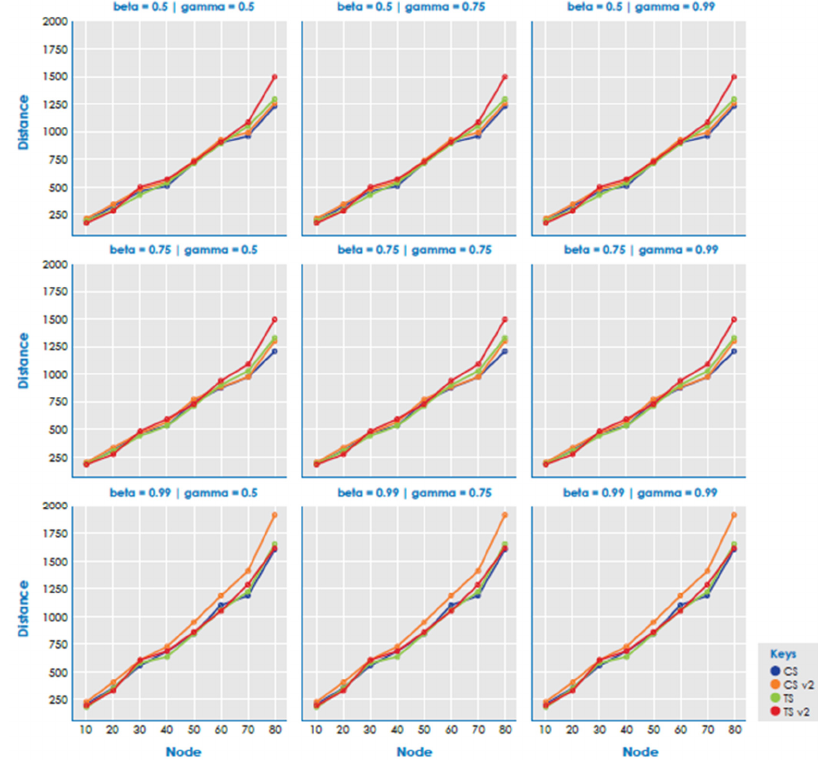
Figure 2. Total distance by methods. α = 0.75 and supermarket = 60%.